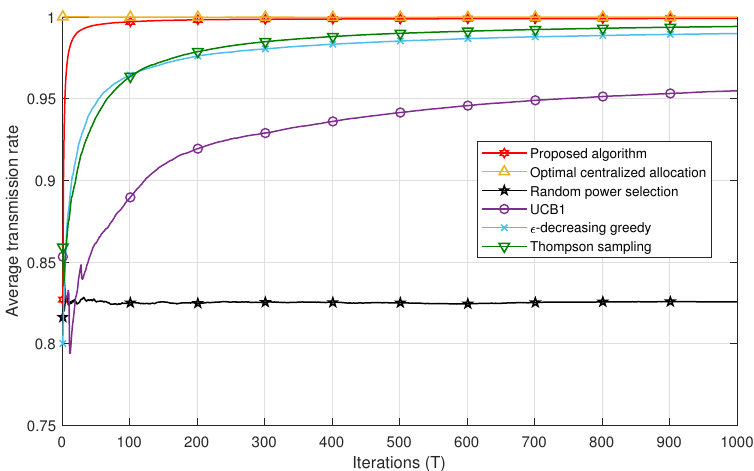
Figure 5. Successful transmission rate comparison for all algorithms in Scenario